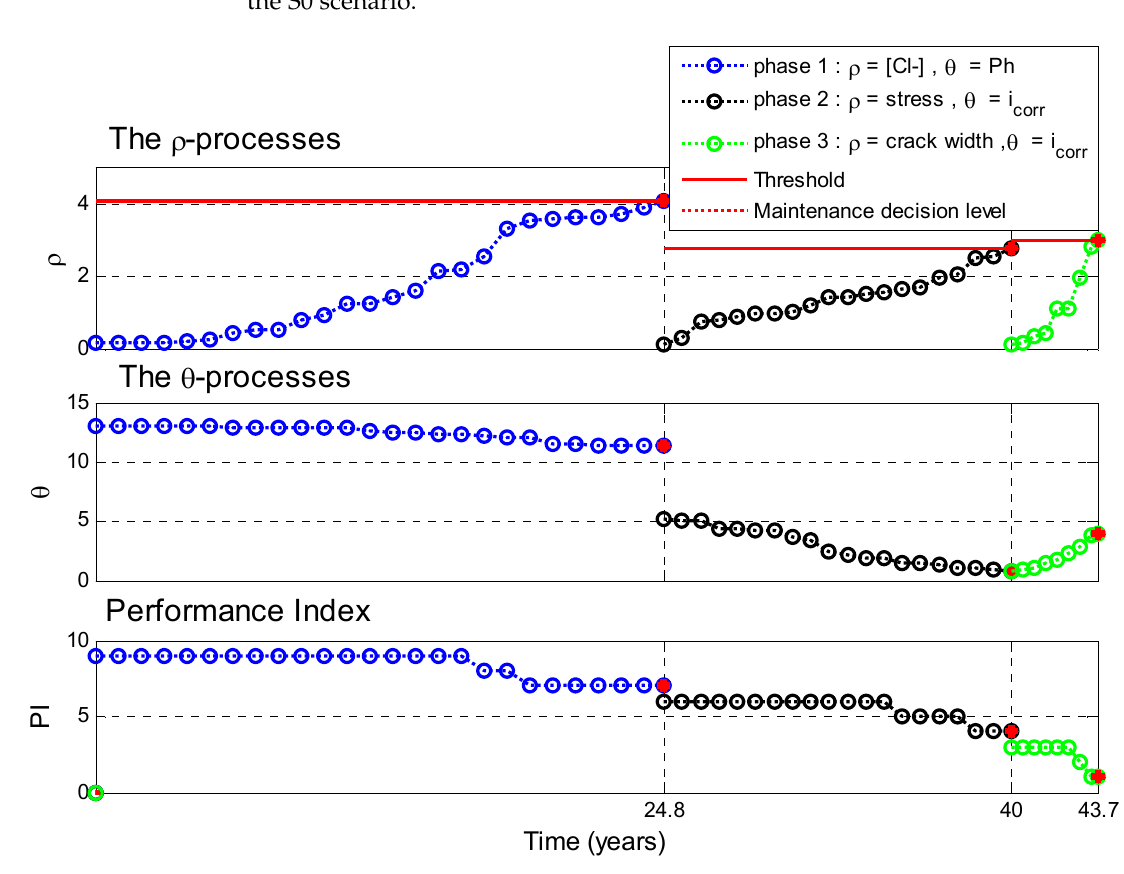
Figure 4. A realisation for S0: an unmaintained structure.